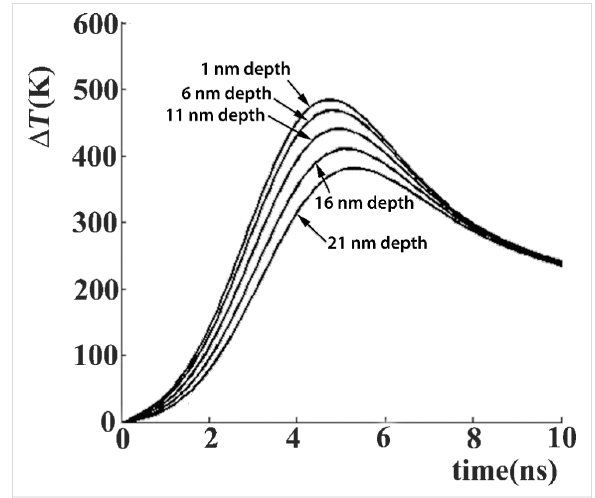
Figure 8: Temperature estimation for different depths beneath the GeTiO film surface during the laser pulse action, considering a Gaussian shape of the laser pulse with a total duration of 7 ns and a laser fluence of 30 mJ/cm 2